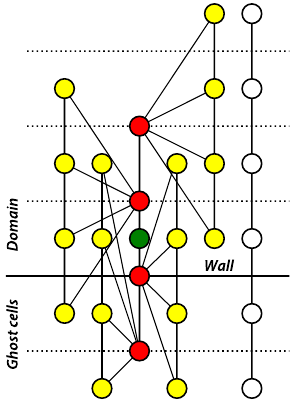
Figure 1. Schematic of the diffusion discretization near the wall. The green node is the evaluation point at the center of the first cell above the wall, the red nodes are the stencil of the divergence oper- ator, and yellow nodes show the stencils of the four gradient oper- ators over which the divergence is evaluated. White nodes indicate the extent of the